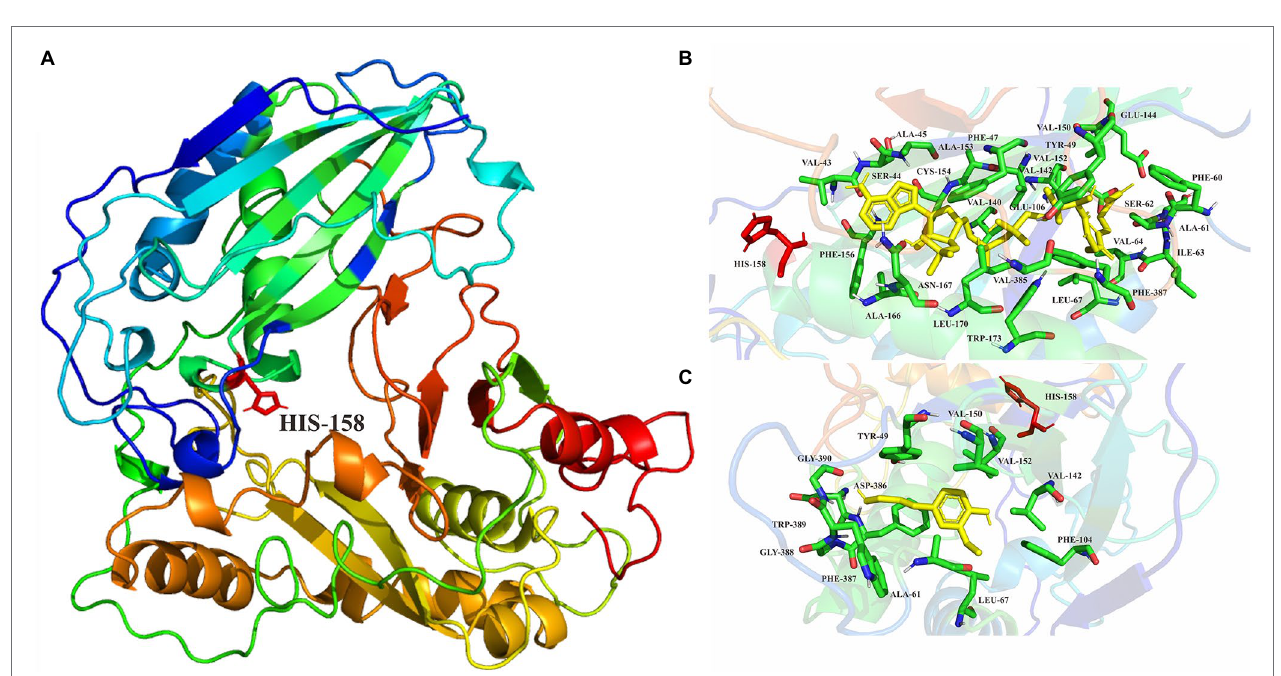
FIGURE 7 | (A) Homology modeling of ScCFAT structure constructed with Modeller. His 158 is shown in stick representation. (B) Enlarged views of molecular docking of ScCFAT with acetyl-CoA. (C) Enlarged views of molecular docking of ScCFAT with coniferyl